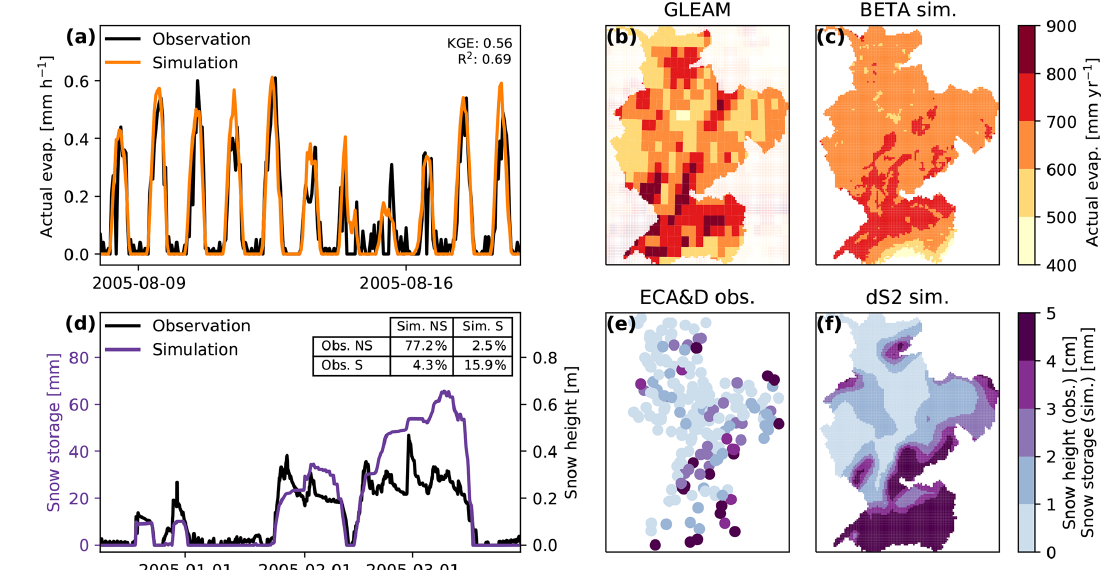
Figure 4. Temporal and spatial validation of evaporation rates (a, b, c) and snow storage (d, e, f) . Panels (a) and (d) show validation with observations from the Rietholzbach research catchment (location can be found in Fig. 1a), with the table in (d) showing the contingency table with the percentage of occurrences with snow (S) and with no snow (NS). Note that panel (d) has two y axes: snow storage for the simulation and snow height for the observations. Panels (b) and (c) show the annual mean actual evaporation of 2005 as determined with both GLEAM and BETA (with a rooting depth of 75cm). Panels (e) and (f) show annual mean snow heights of 2005, as observed in the ECA&D dataset (snow height in cm) and simulated with dS2 (snow storage in